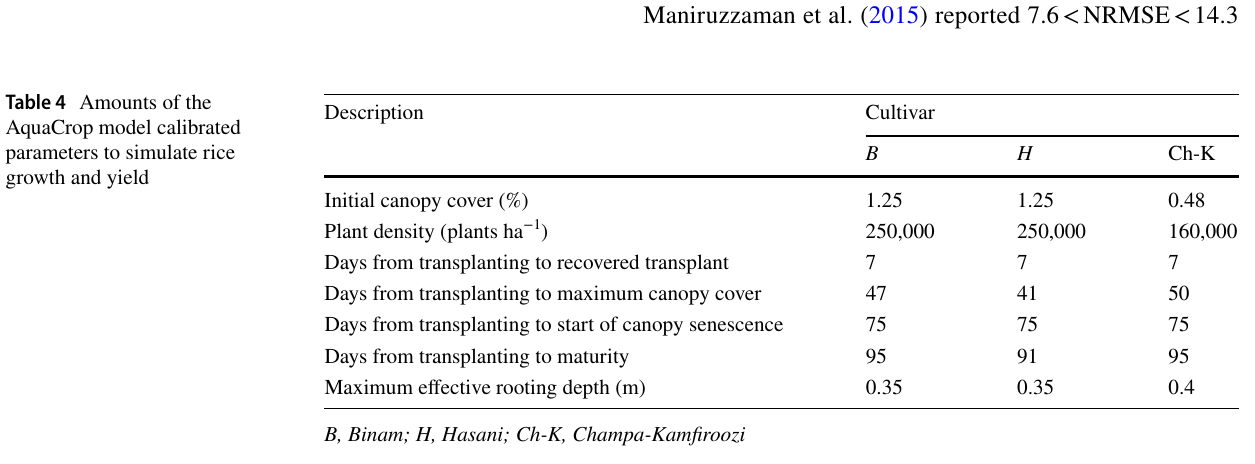
Table 5 Amounts of ME, RRMSE and C RM of canopy cover simulation for different irrigation treatments in